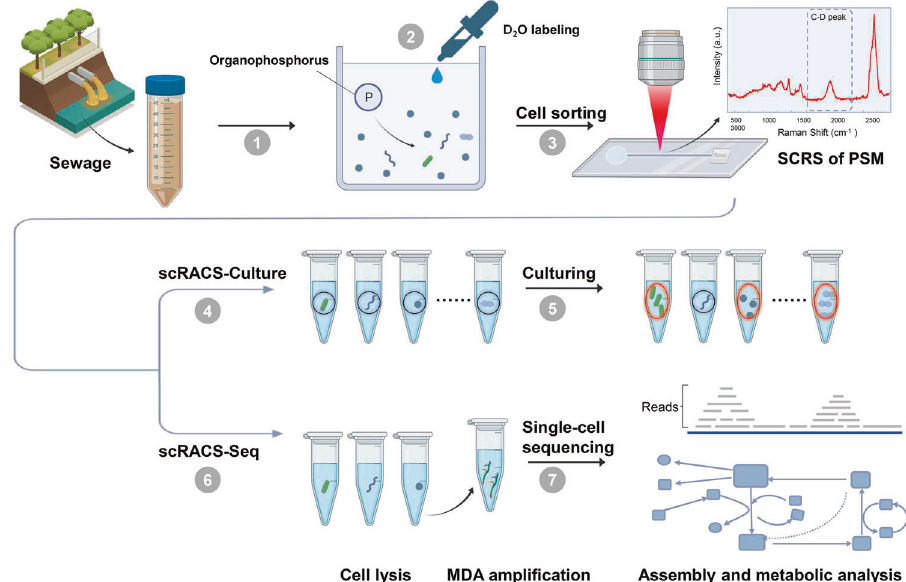
Fig. 1 Work fl ow of scRACS-Seq/Culture for revealing organic-PSM in the sewage that links genotype to phenotype (metabolic activity). ① Cells in the sewage were extracted by Nycodenz density gradient separation (NDGS). ② For sorting organic-PSM, the sewage extract was incubated under the conditions of adding lecithin as organic phosphorus in dephosphorization sewage in 50%-D 2 O for 24 h. ③ Organic-PSM were identi fi ed based on the preset C-D ratio threshold (metabolically active) in SCRS, and then sorted out in the RAGE chip, as a one-cell- encapsulated droplet, in an one-cell-one-tube manner. ④ For scRACS-Culture, pL-volume culture was employed for seven days, following by μ L volumes for another seven days in broth medium. ⑤ Single-cell-derived organic-PSM cultures were obtained for further validation. ⑥ For scRAGE-Seq, the RAGE-sorted cells were lysed, and then the genomic DNA was ampli fi ed by MDA and then processed for 16S rRNA sequencing and whole-genome shotgun sequencing. ⑦ Assembly and annotation of the single-cell shotgun sequencing reads, and then the metabolic pathways were reconstructed to establish the link between genotype (sequencing based) and the metabolic phenotype (SCRS based) at precisely one-cell